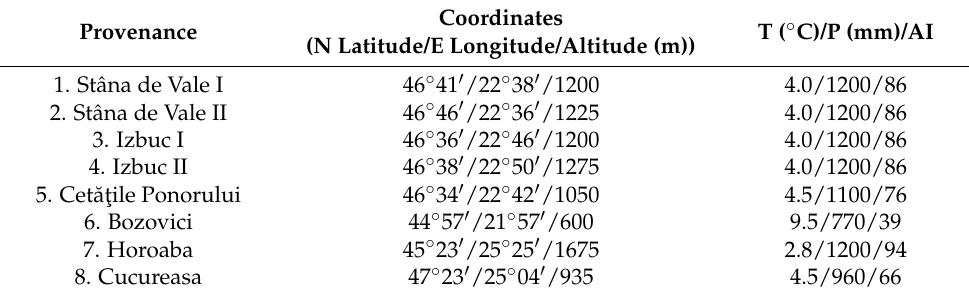
Table 1. The location of the provenances and climatic conditions.